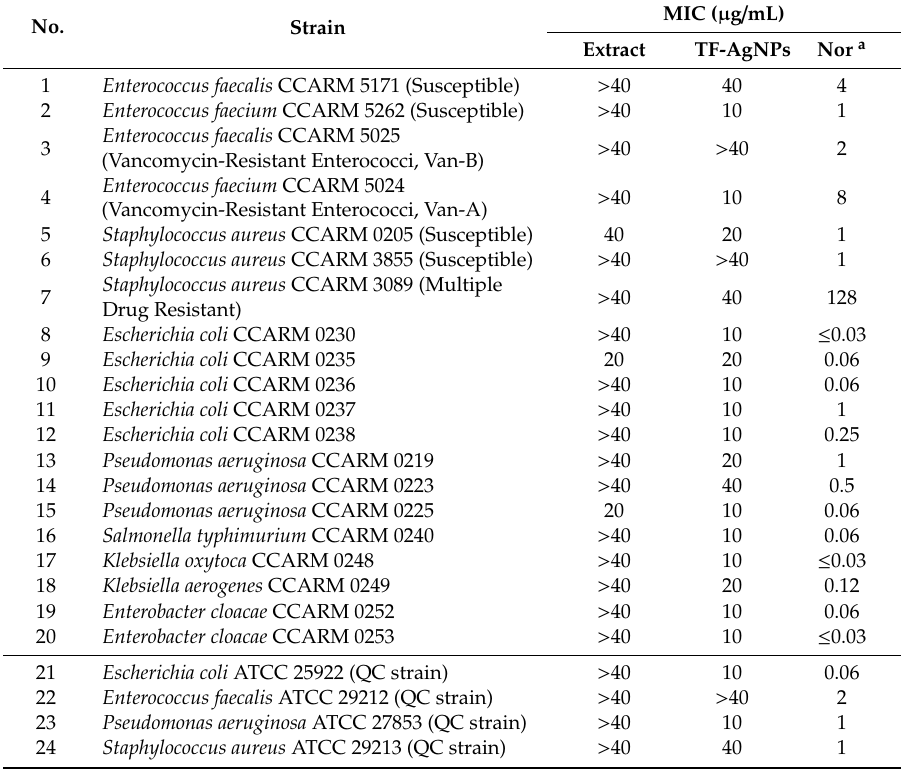
Table 1. Antibacterial activity of the extract and T. farfara silver nanoparticles (TF-AgNPs) measured by the minimal inhibitory concentration (MIC)